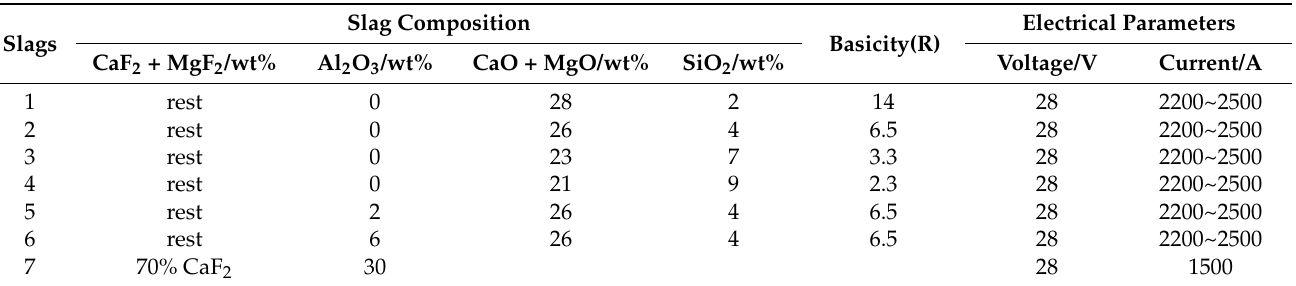
Table 2. Experimental